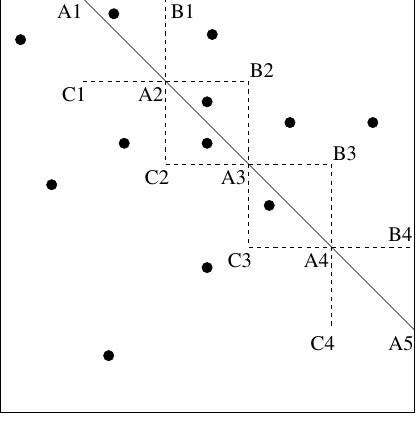
Figure 1. Approximating points below line (cid:96) with m =